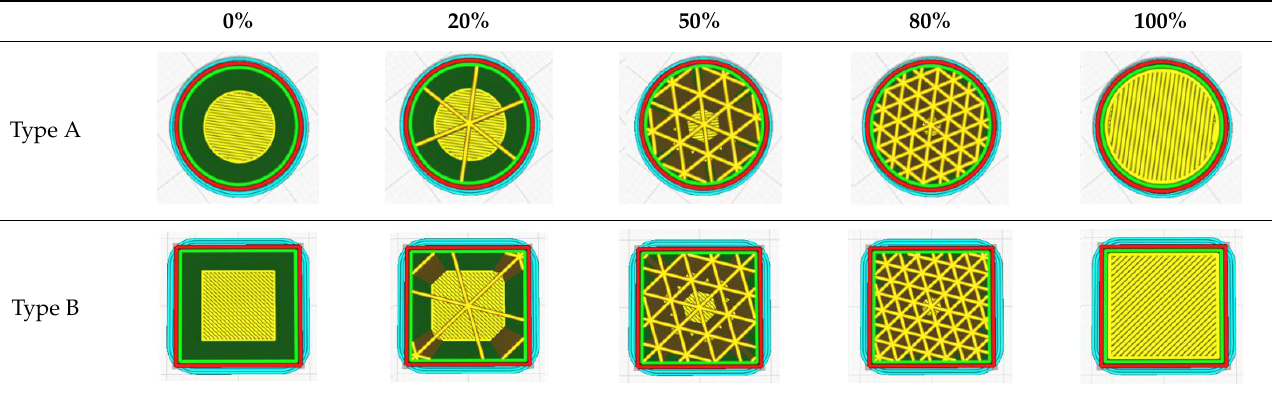
Table 3. Filling percentages of Type A cylindrical and Type B prismatic specimens.